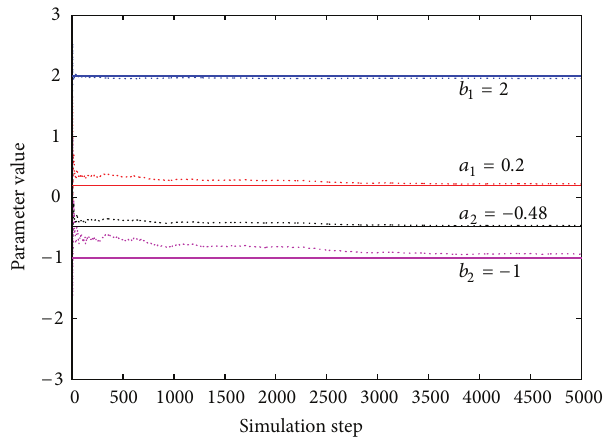
Figure 5: Estimation result of 𝜃 in System 3 with ARMA input process.